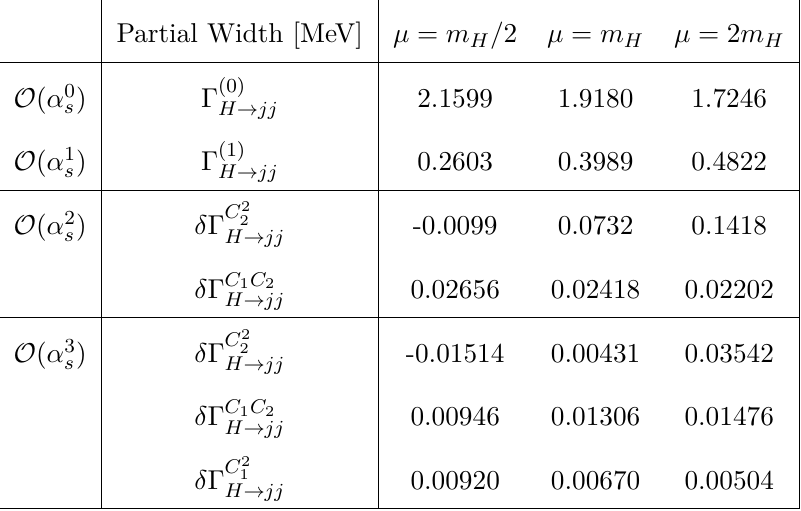
Table 1. Inclusive partial width results for H → bb at LO, and higher order coefficients for NLO y 2 contributions, and the top induced pieces at O ( α 2 b between the boundary constants of 17 integrals. The remaining three integrals I